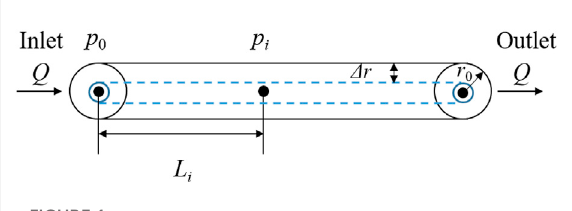
FIGURE 1 Illustration of the geometry of the pipeline and the hydrate